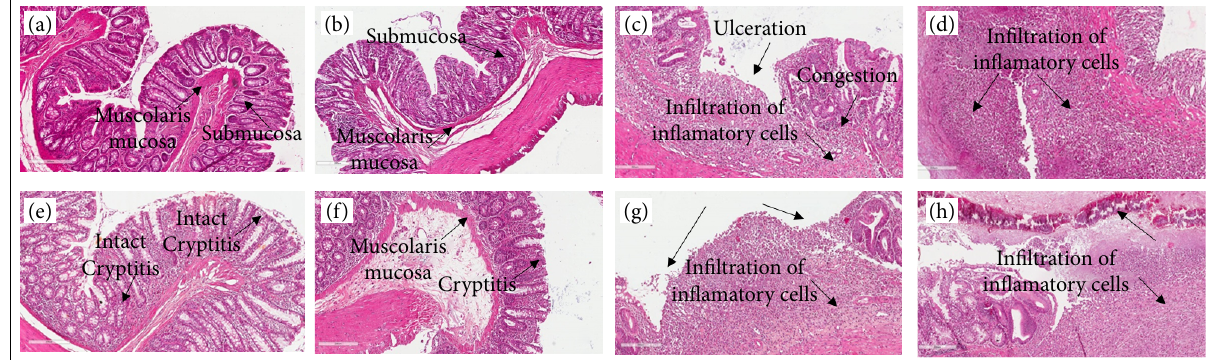
Figure 1 - Histopathology of the colon, two images per group. Lesions are indicated by arrows. ( a and b ) Normal mucosa with regular structure from the normal control group rats. ( c and d ) There are ulceronecrotic inflammation and abscesses from the colitis/normal saline group rats, in both images. ( e and f ) These images show that the colitis microscopic status in colitis/ curcumin group was significantly recovered. Criptitis and submucous edema are observed. ( g and h ) Two representative images from the colitis/mesalazine group rats show mucosal ulcers, areas of necrosis, vascular congestion,